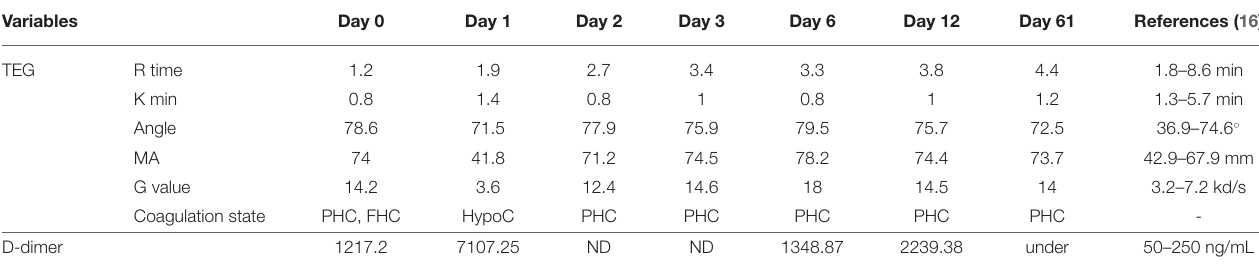
TABLE 1 | Serial thromboelastographic and D-dimer results in a dog with unilateral forelimb arterial thrombosis following thrombolytic therapy.